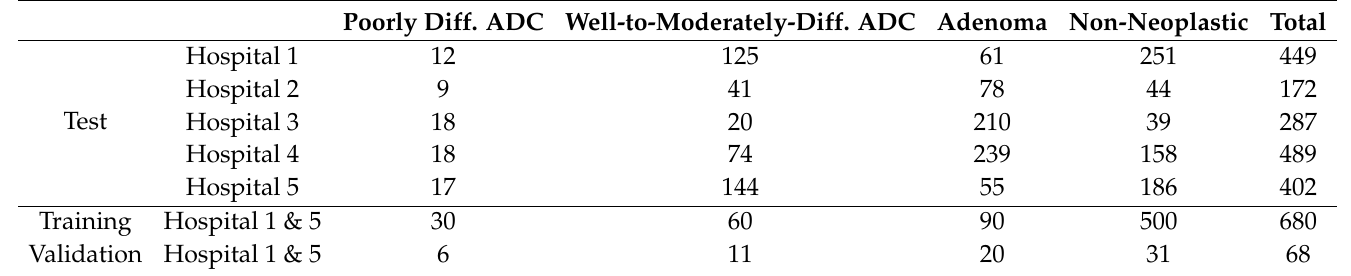
Table 1. Distribution of WSIs in the training, validation, and test sets.